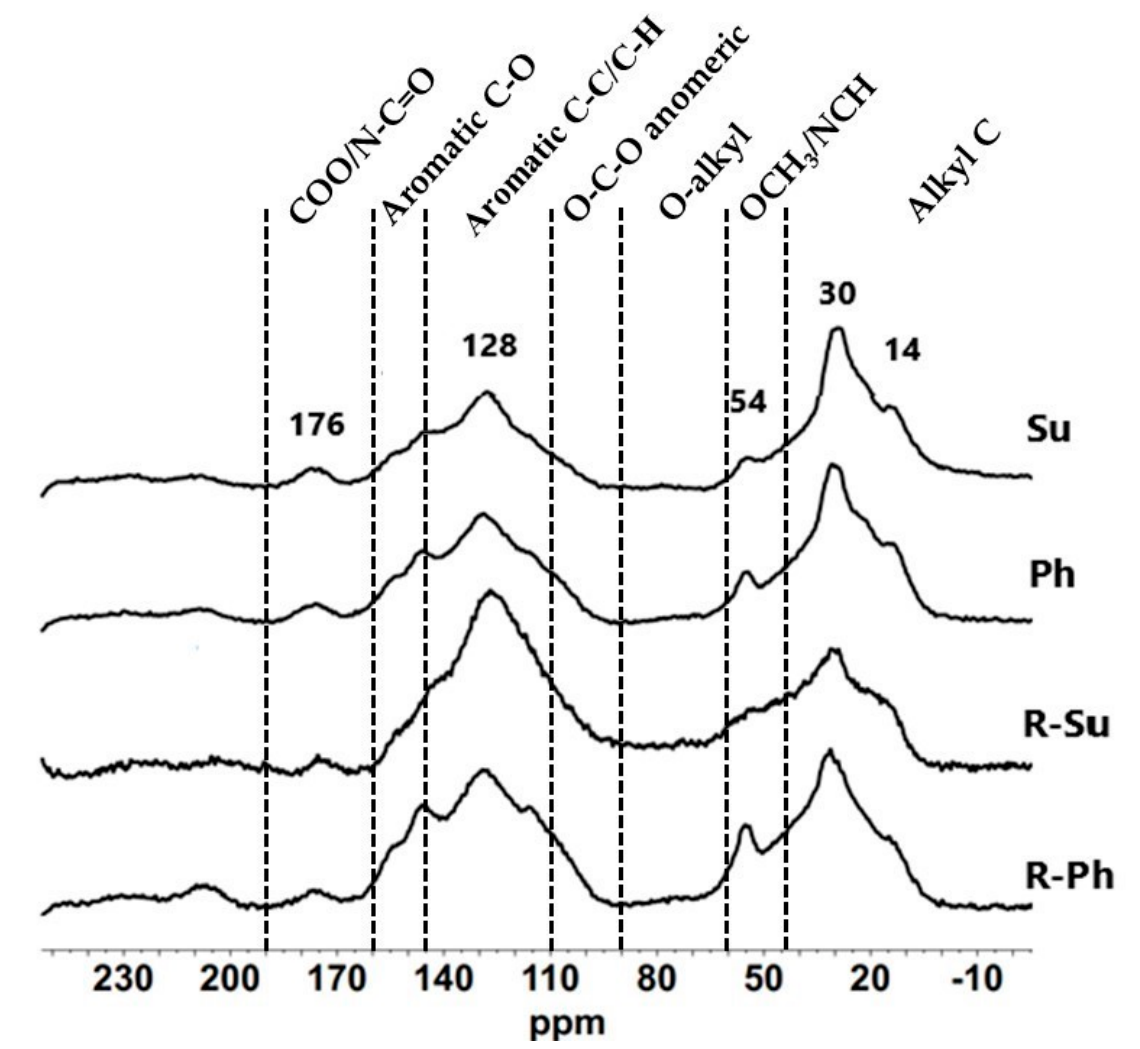
Figure 2. Solid-state 13 C-NMR spectra of hydrochars (Su, Ph, R-Su, and R-Ph).